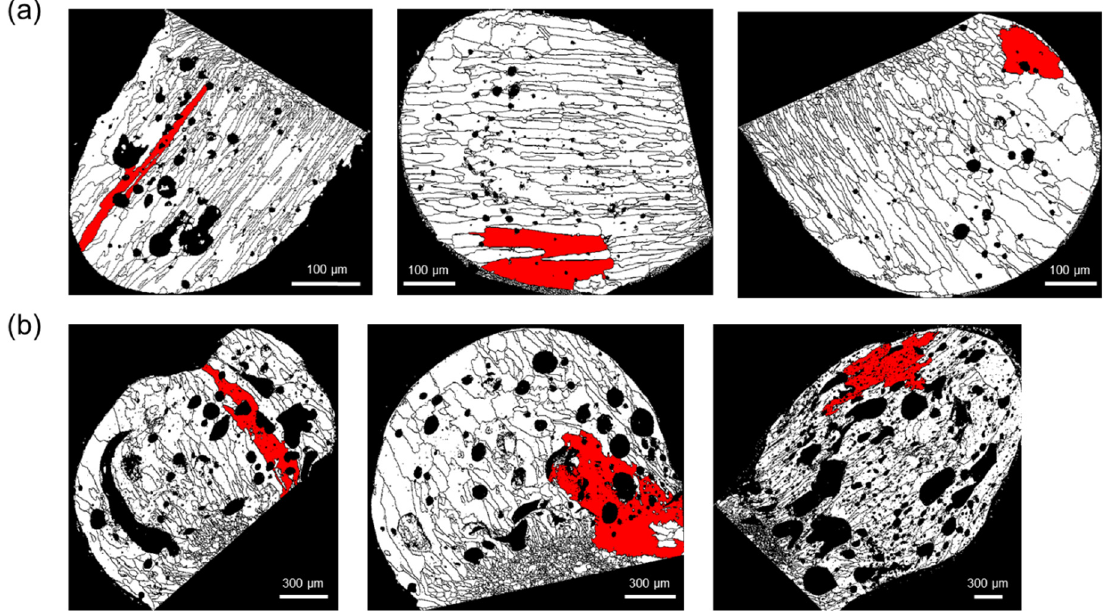
Figure 8. Representation of the grains of maximum size: ( a ) PABs and ( b ) SABs.